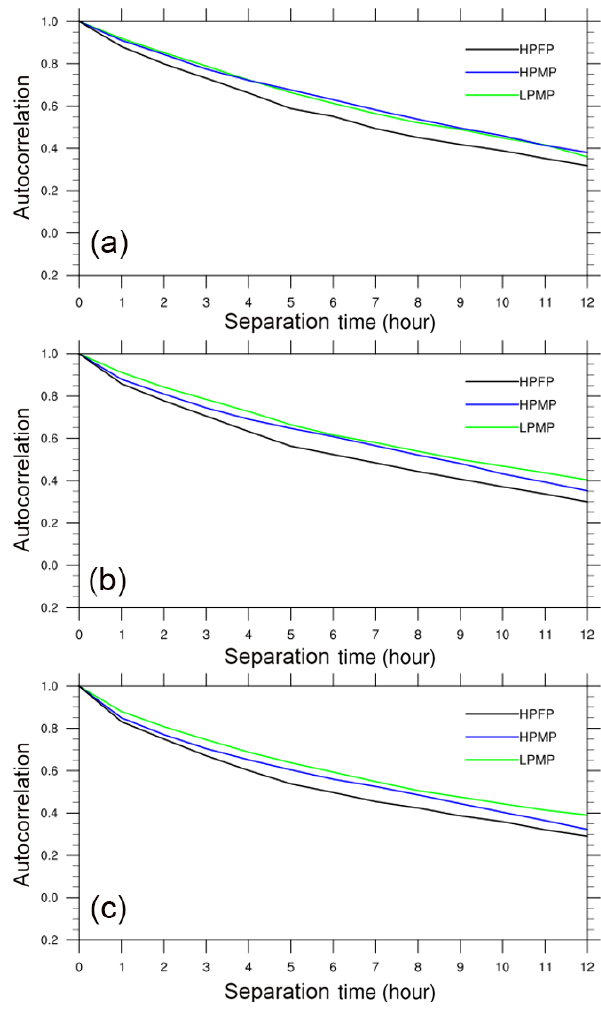
Figure 13. Same as in Fig. 6 but for the averaged temporal autocor-